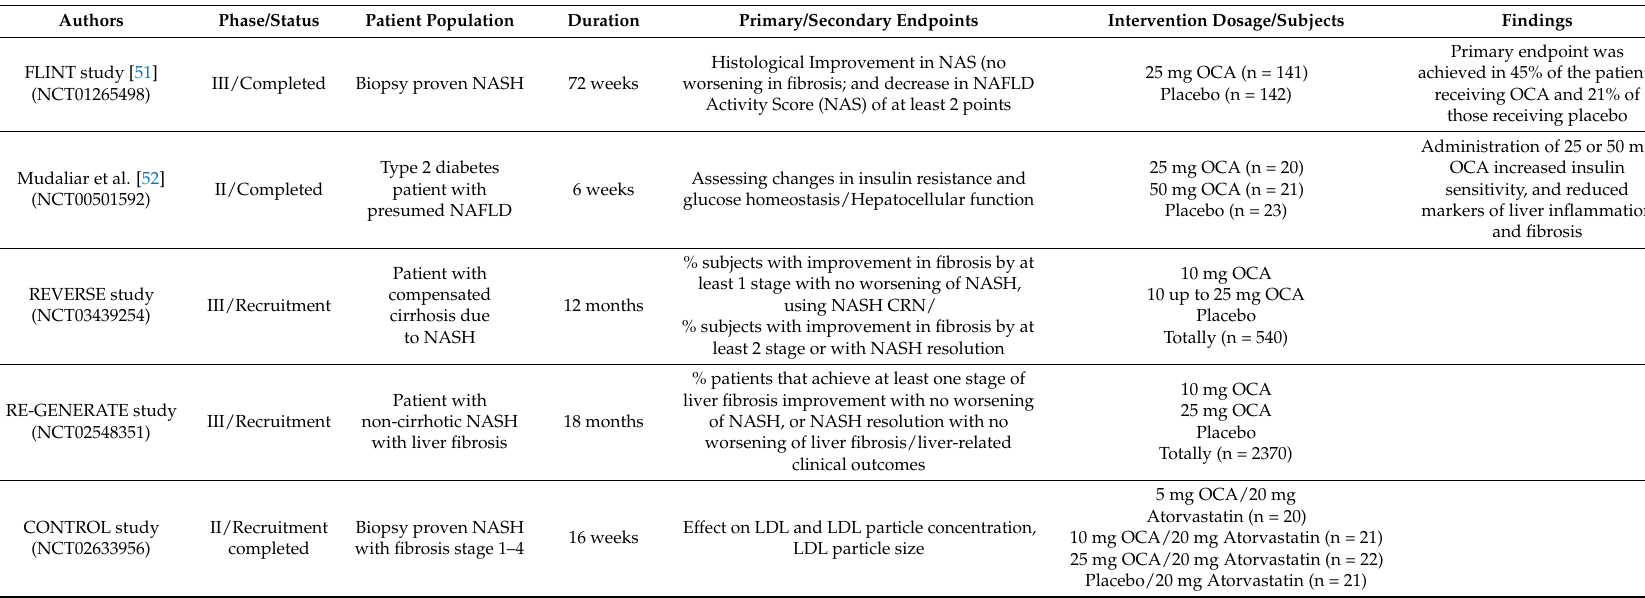
Table 1. Randomized clinical trials using obeticholic acid (OCA) in patients with nonalcoholic fatty liver disease (NAFLD) and nonalcoholic steatohepatitis